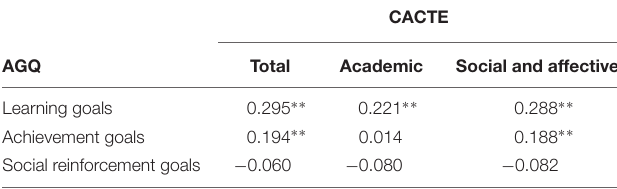
TABLE 8 | Pearson Correlations between AGQ and CACTE Factors.